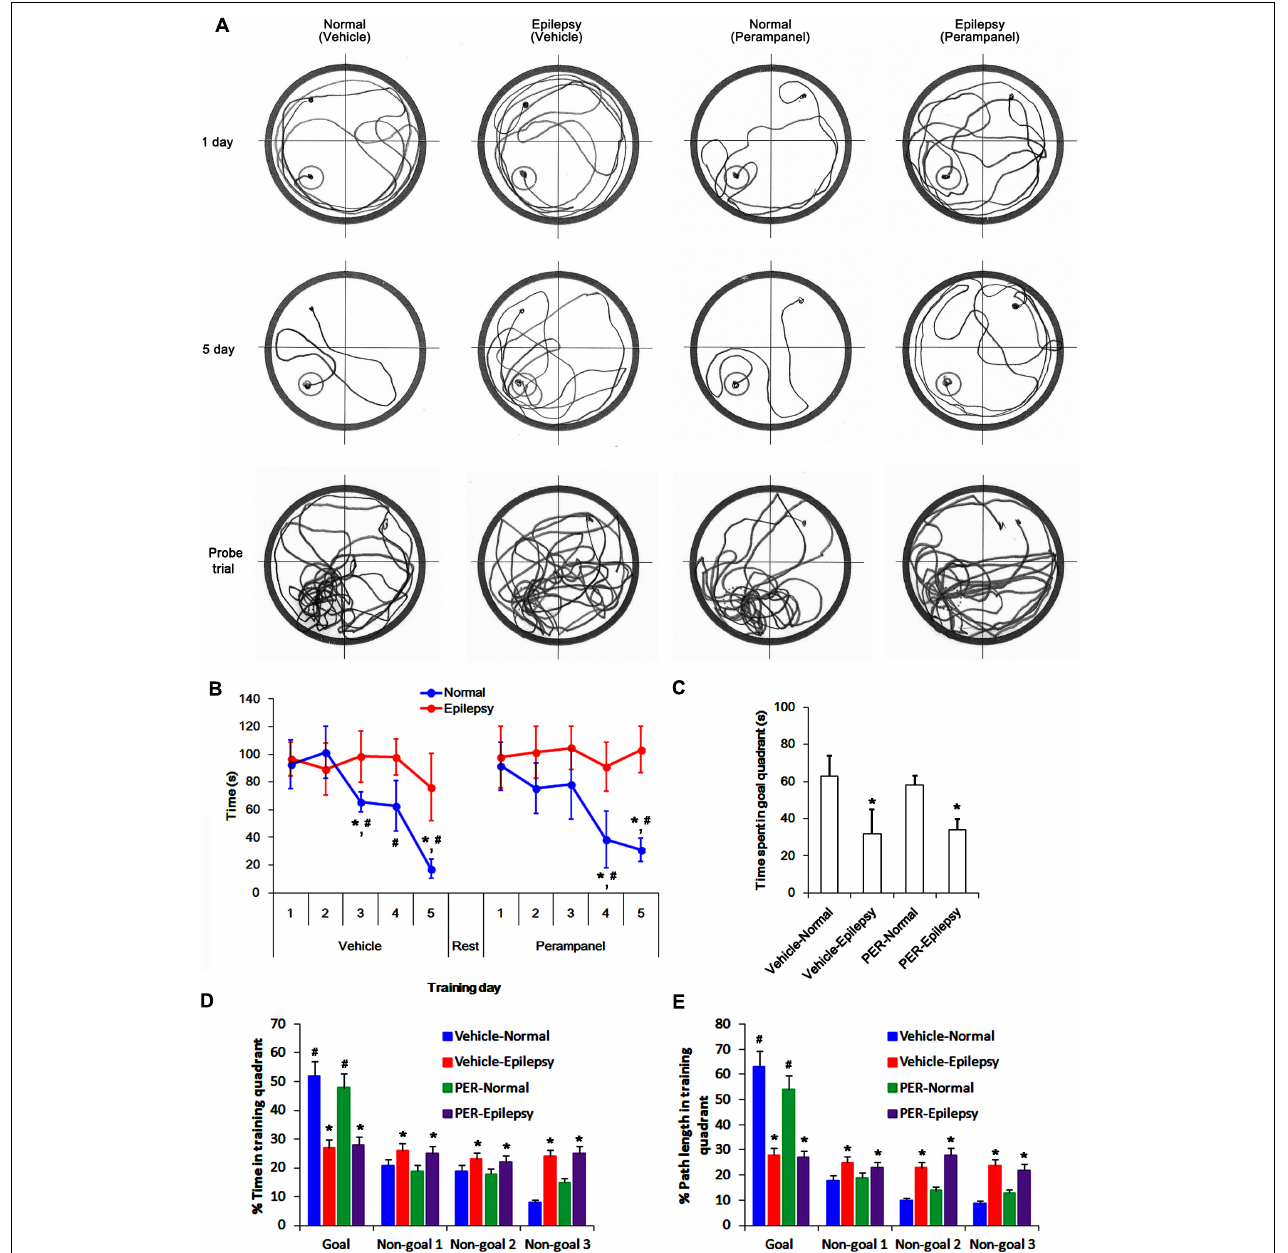
FIGURE 12 | Profiles of behavioral test by Morris water maze. (A) Representative traces of swimming plot in Morris water maze test. (B) The quantitative analyses of the Morris water maze. Over 5 days of training, normal rats improve their ability to find the submerged platform, which exhibits decreasing escape time, while epileptic rats do not. Perampanel (PER) does not affect escape duration in normal and epileptic rats. ∗ , # p < 0.05 vs. first day and epileptic rats, respectively; n = 5, respectively. Error bars in graphs indicates SEM. (C–E) The quantitative analyses of the probe trials. Perampanel (PER) does not affect the time spent in goal quadrant (C) and the percentage of the time spent (D) and the path length (E) in goal quadrant in normal and epileptic rats. ∗ , # p < 0.05 vs. normal animals and non-goal quadrants, respectively; n = 5, respectively. Error bars in graphs indicates